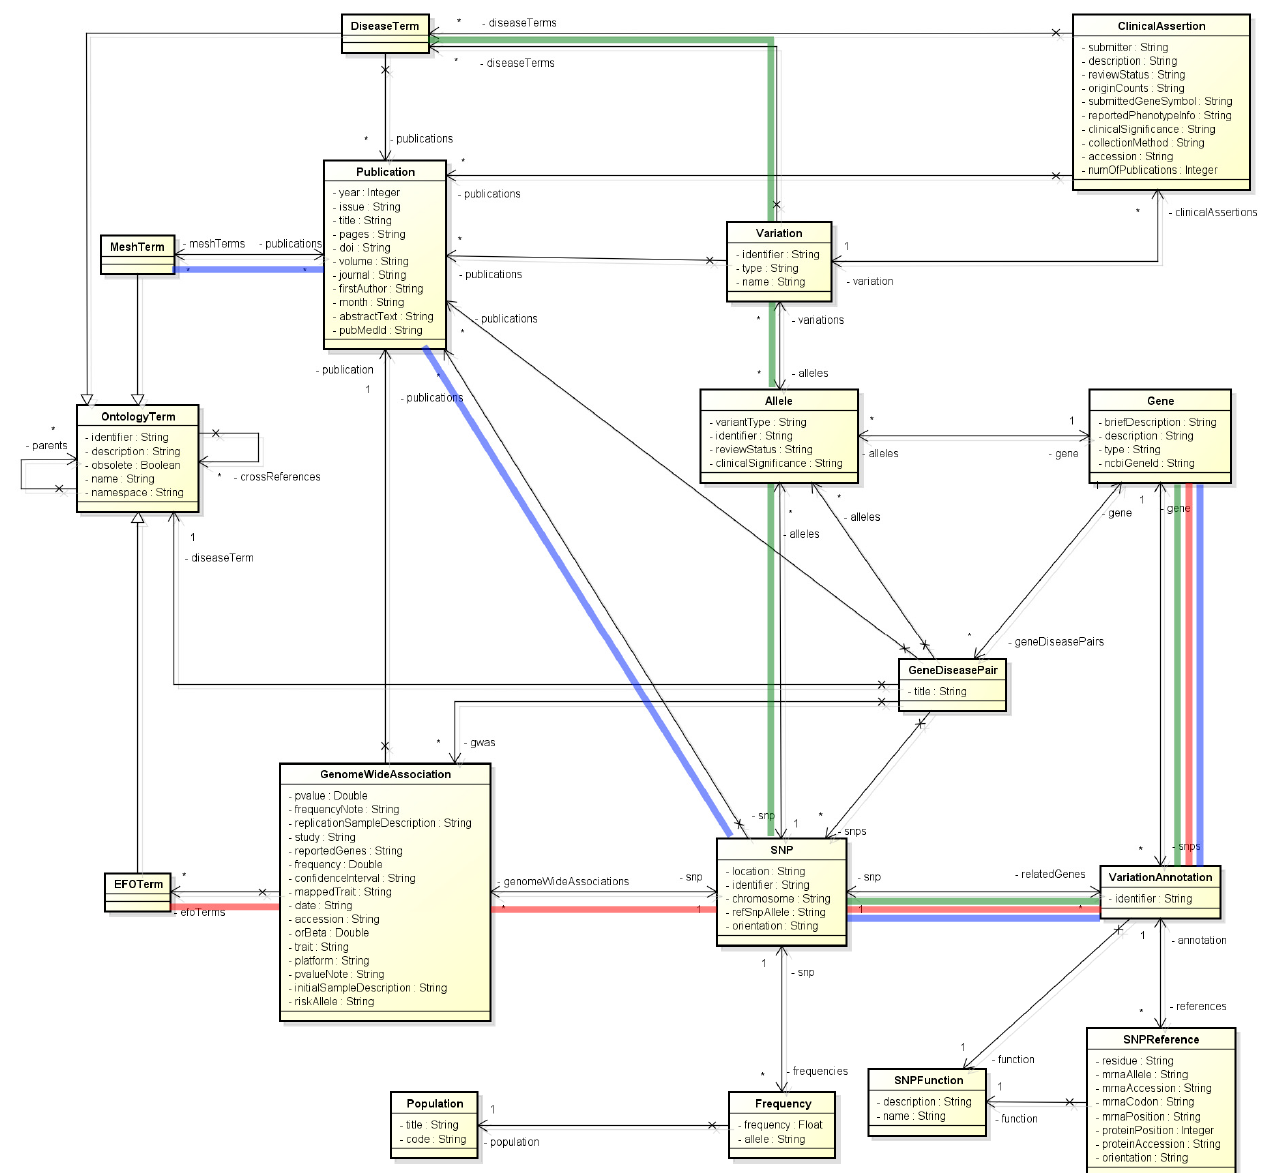
Figure 2. The new implemented data model. The colored lines indicate how the genes and diseases/phenotypes are associated in the post processing